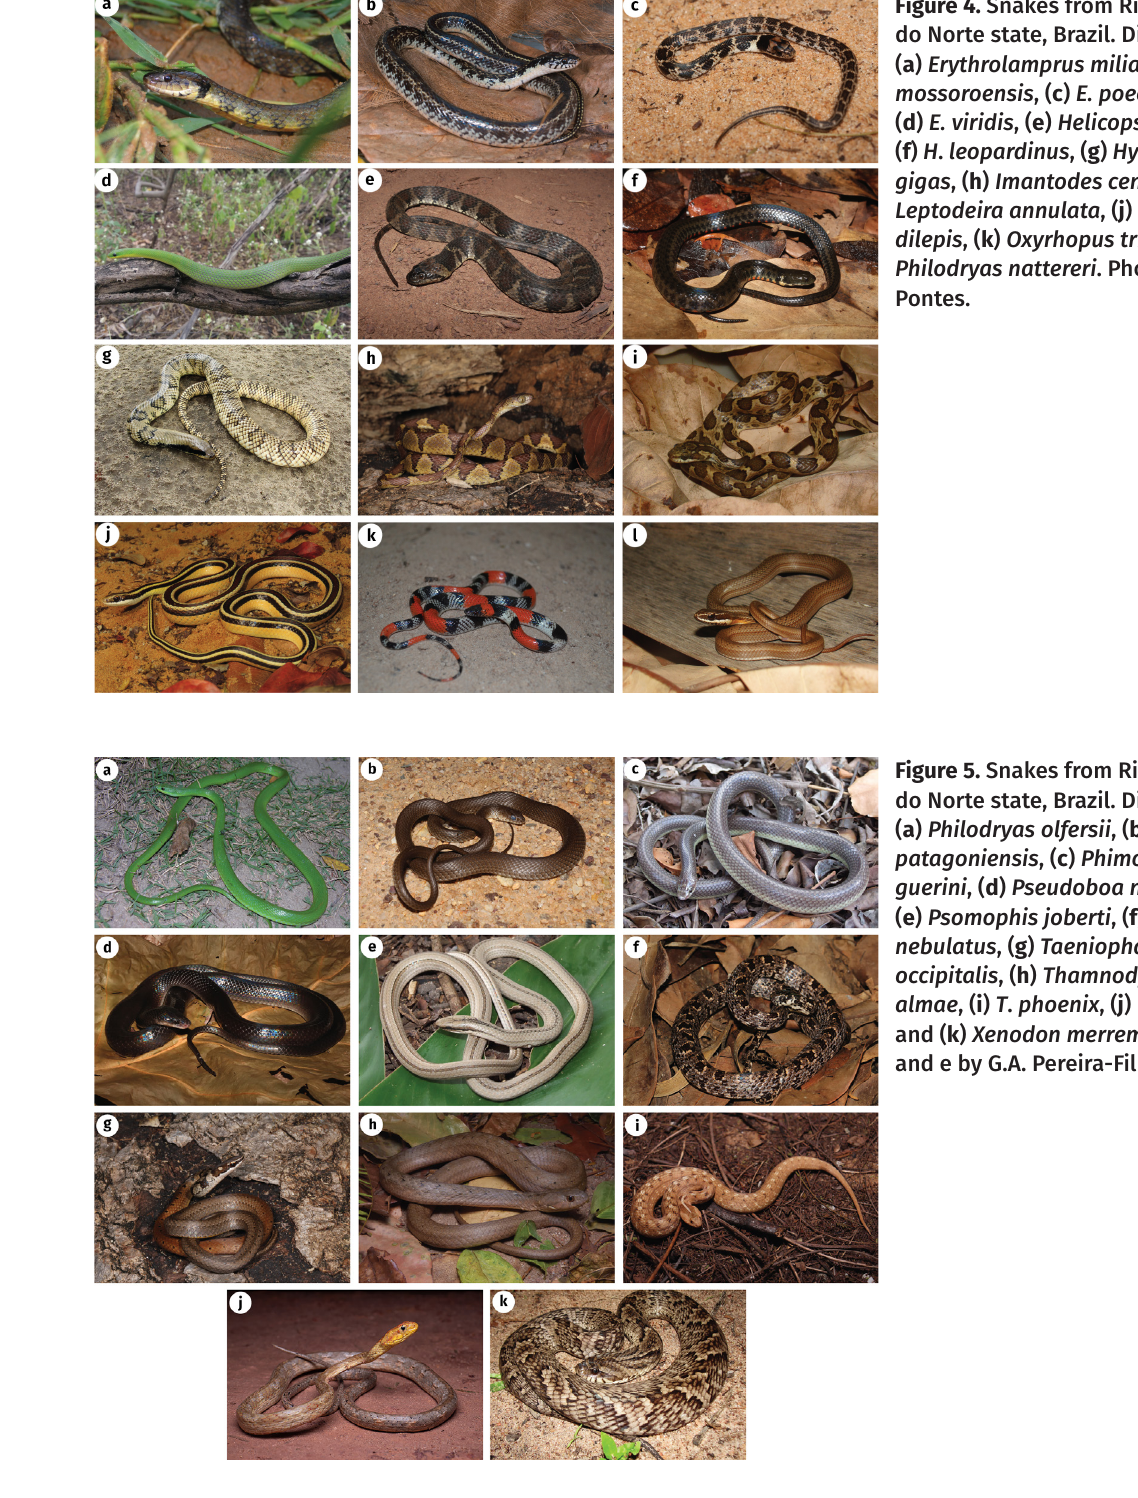
Figure 4. Snakes from Rio Grande do Norte state, Brazil. Dipsadidae: ( a ) Erythrolamprus miliaris , ( b ) E. mossoroensis , ( c ) E. poecilogyrus , ( d ) E. viridis , ( e ) Helicops angulatus , ( f ) H . leopardinus , ( g ) Hydrodynastes gigas , ( h ) Imantodes cenchoa , ( i ) Leptodeira annulata , ( j ) Lygophis dilepis , ( k ) Oxyrhopus trigeminus , ( l ) Philodryas nattereri . Photo d by B.